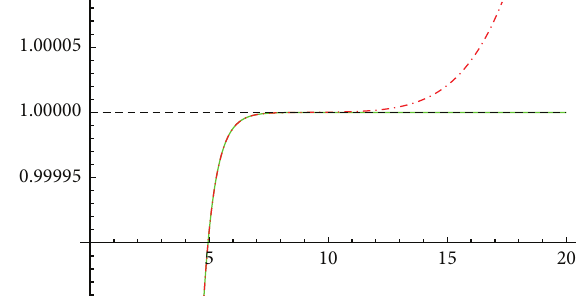
Figure 4: The Pad´e approximant [13/12]{𝜙 20 (𝑥)} (dot-dashed line), far-fieldapproximation 𝜑 3 (𝑥) (dashedline),andexactsolution 𝑢 ∗ (𝑥) (solid